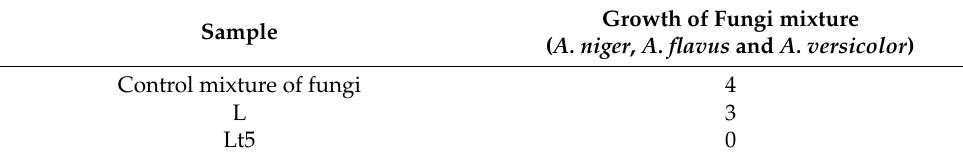
Table 4. Fungistatic properties of polymer samples in accordance with ISO 846:2019